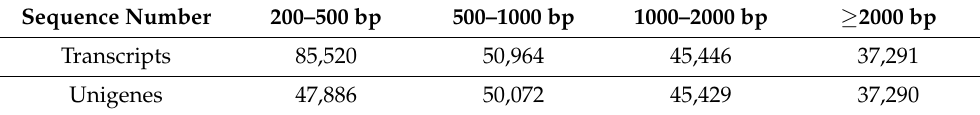
Table 3. Length statistics of transcripts and unigenes from the transcriptome assembly.